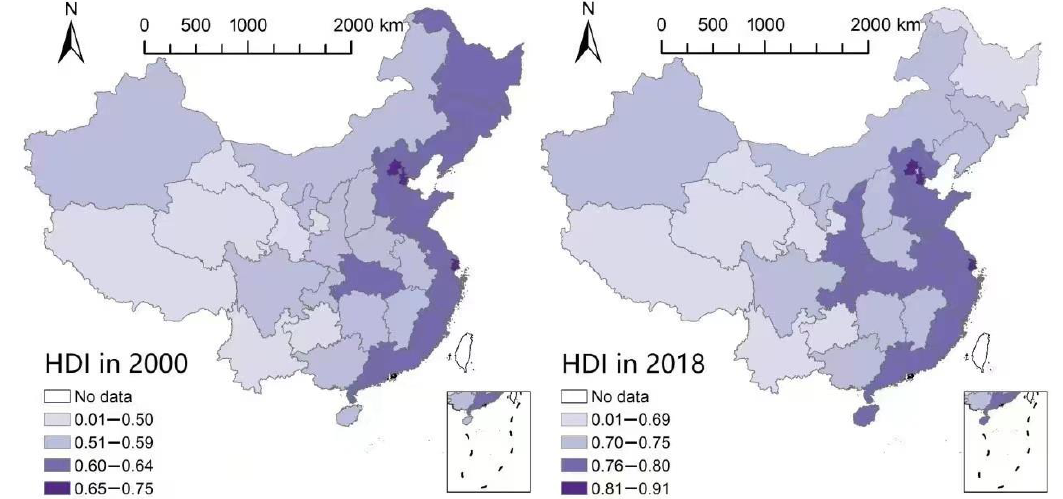
Figure 6. Spatial Distribution of HDI Constructed with Lighting Data.